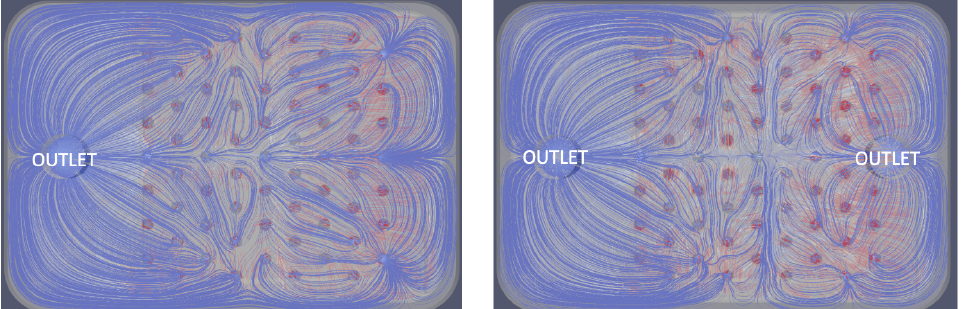
Figure 13. Comparison of the streamlines viewed from the top for the designs with one outlet ( left ), cf. Figure 9, and with two outlets ( right ), cf. Figure 12. The top view shows the outlets, the slow flow (blue) in the top gasket, and the faster flow (red) in the islet chamber. The same velocity scale was used for both pictures. We see stronger flow through the islet chamber on the right (two outlets). In particular, the transverse flow, away from the ultrafiltrate channels, is much stronger in the case of two outlets. This can also be seen in Figure 12 (bottom). A combination of the presence of the second outlet and the “misalignment between the islet chamber and the two inlet membranes in the right half of the chamber is responsible for the increase in transverse (diagonal) flow.